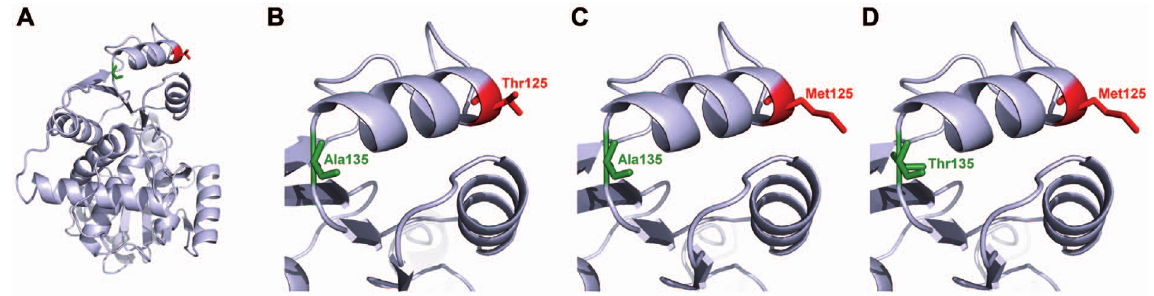
Figure 4 Compensated mutation in human ornithine transcarbamylase. (A) Structure of wild-type human OTC. (B) View on helix 3, with residues 125 and 135 shown in red and green, respectively. (C) The disease-causing Thr125 ™ Met mutation, modeled structure. (D) A compensatory Ala135 ™ Thr in addition to the Thr125 ™ Met